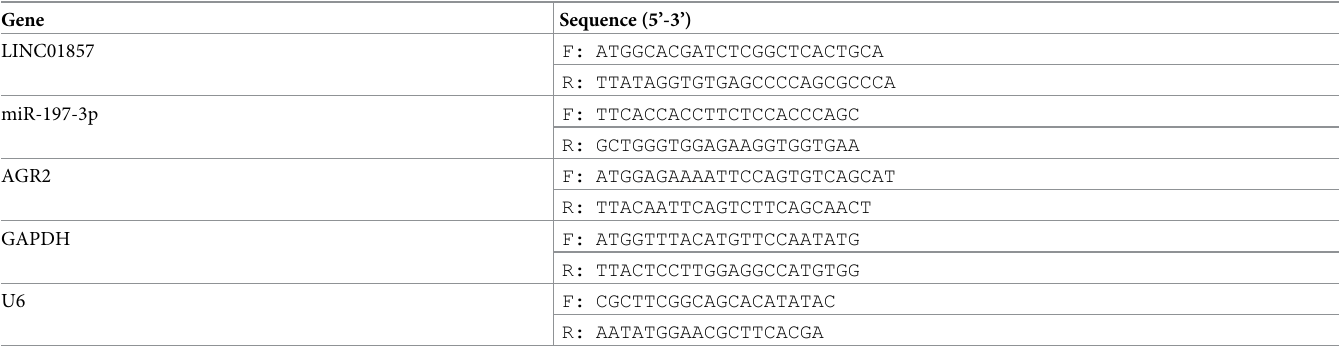
Table 1. Primers sequence of